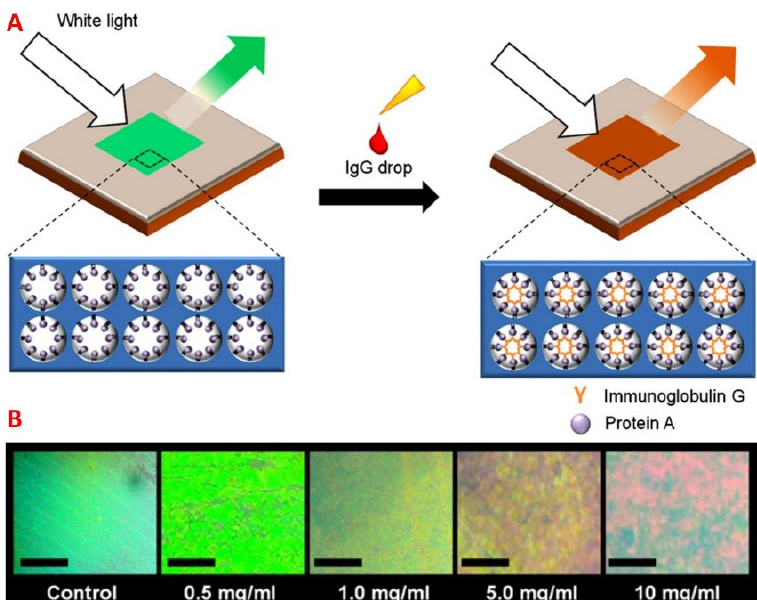
Figure 8. ( A ) Mechanism of the inverse‐opal biosensor. The addition of IgG antibodies binding to the sensor causes a change to the refractive index of the matrix. ( B ) The change in color from green to red with increasing antibody concentrations observed under an optical microscopy. The scale bars are 0.5 mm. Reprinted and adapted with permission [100]. Copyright 2013, Elsevier.